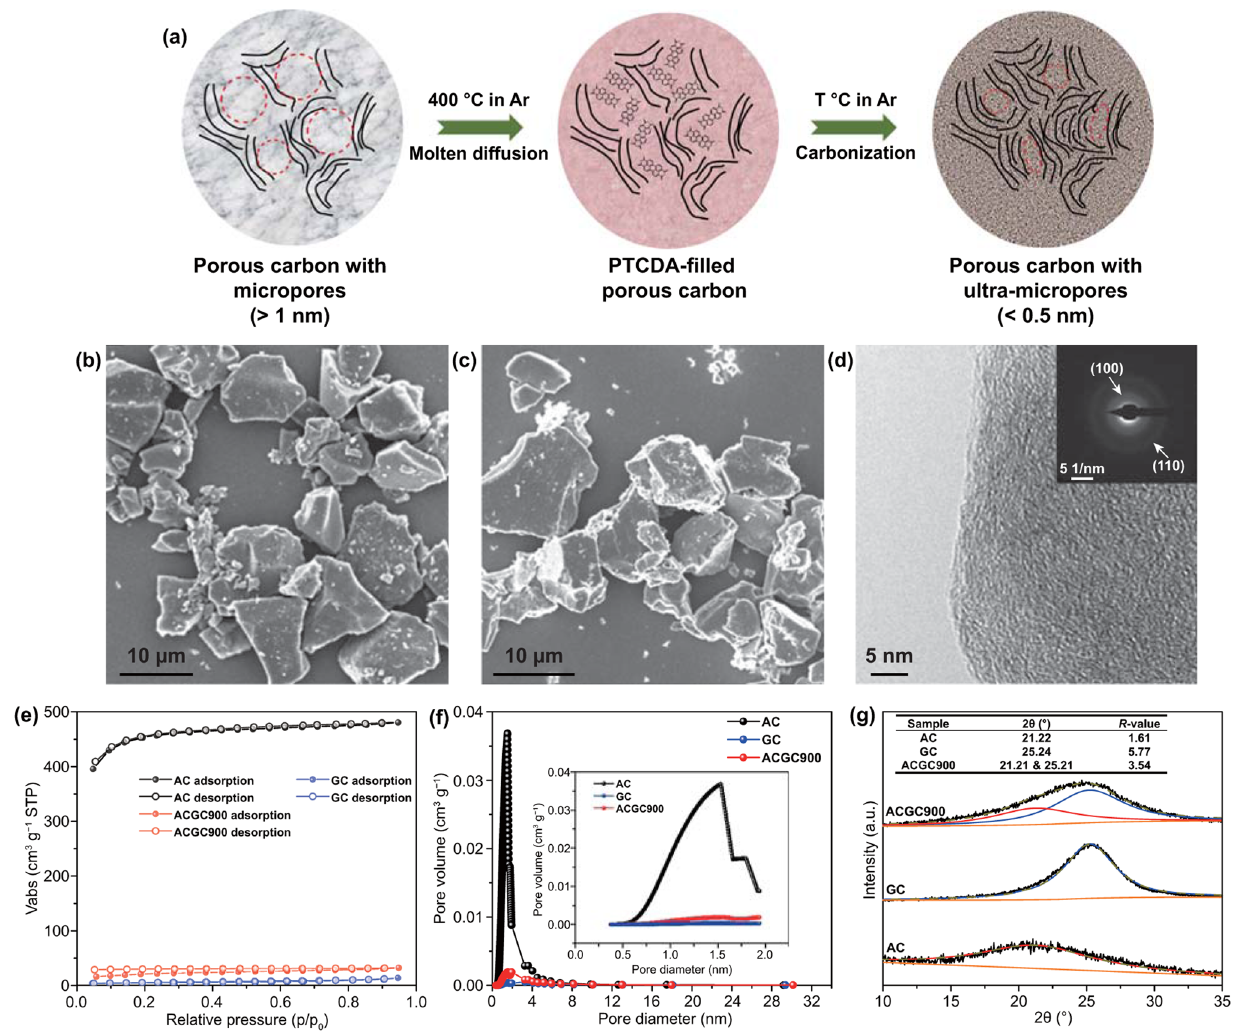
Fig. 1 Characterizations of the AC, GC and ACGC900. a Scheme of the molten diffusion–carbonization strategy (T represents the carboniza‑ tion temperature). SEM image of b AC, and c ACGC900. d TEM image of ACGC900 and corresponding selected area electron diffraction (SAED) pattern (inset). e N 2 adsorption/desorption isotherm, f pore size distribution from N 2 adsorption/desorption measurement and g peak fitting of the (002) peaks in the XRD